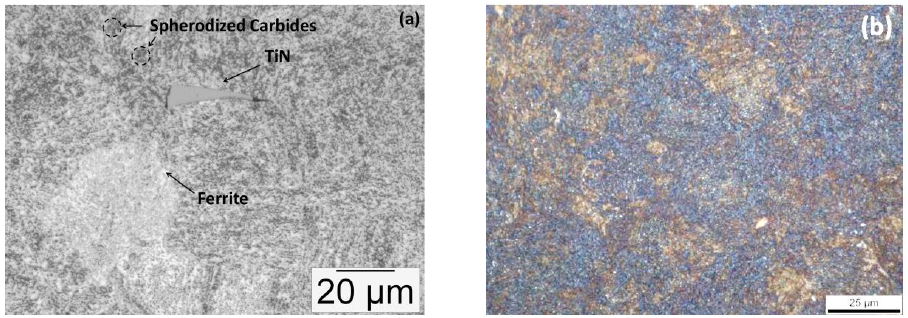
Figure 4. ( a ) Initial microstructure of the CrMo steel in the soft annealed condition ( b ) Microstructure of the CrMo steel after UFHT. Blue and brown regions indicate the appearance of bainite and martensite, respectively, while white areas indicate the existence of carbides (or possibly retained austenite).